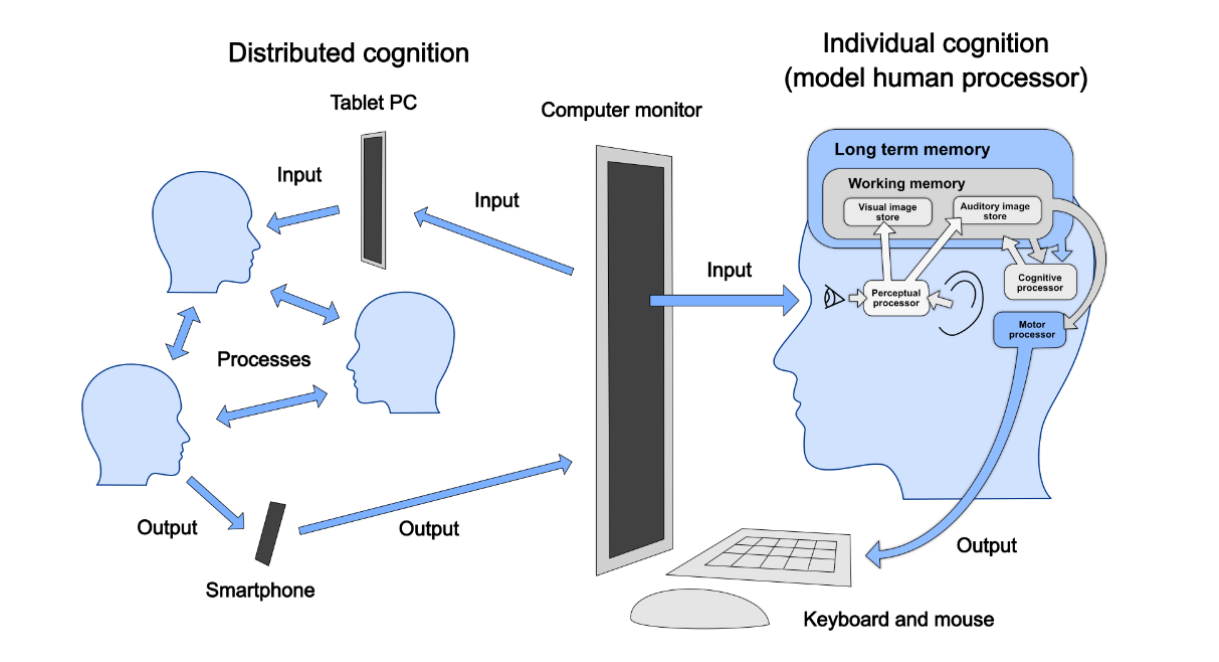
Figure 2. The model human processor: a model of how long it takes to process information (from perception to action) and how we can use the limited “chunks” of information in working memory. Building on the idea of a model human processor is the concept of “distributed cognition,” with multiple humans and devices working together. Adapted from Card et al